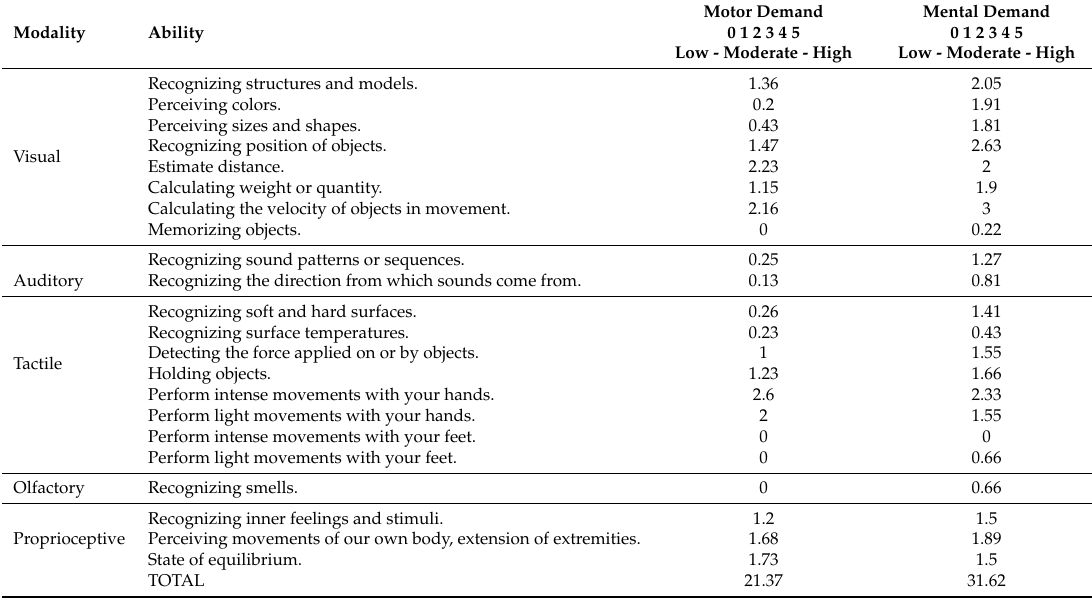
Table 4. Mean for the abilities and demands of SIBMER version